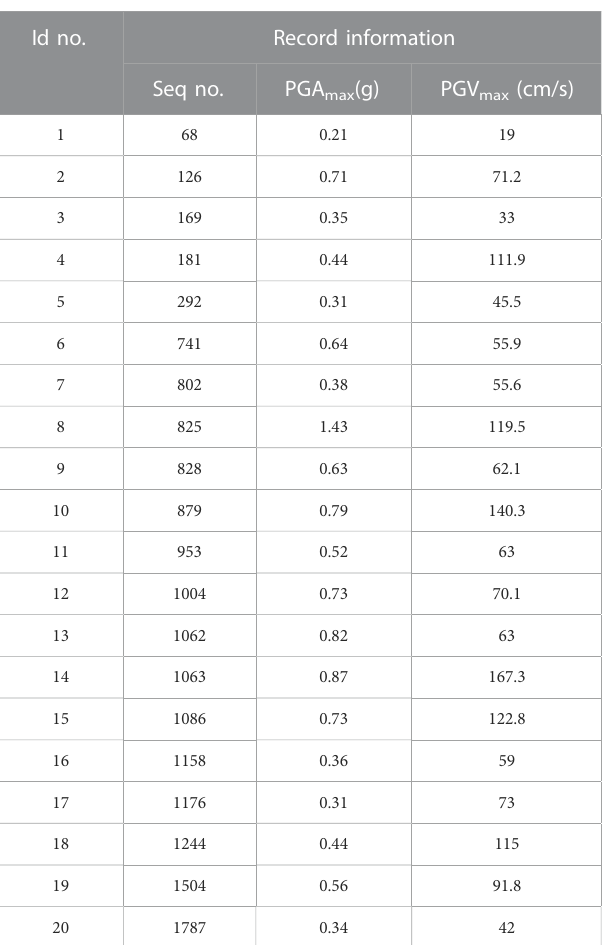
TABLE 1 Ground motion information.